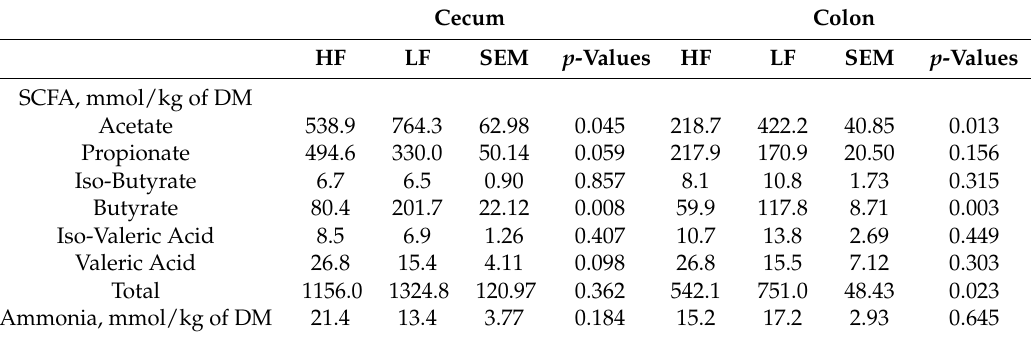
Table 5. Effect of diet on concentrations of short-chain fatty acids (SCFA) and ammonia in cecal and colonic digesta. Cecum Colon